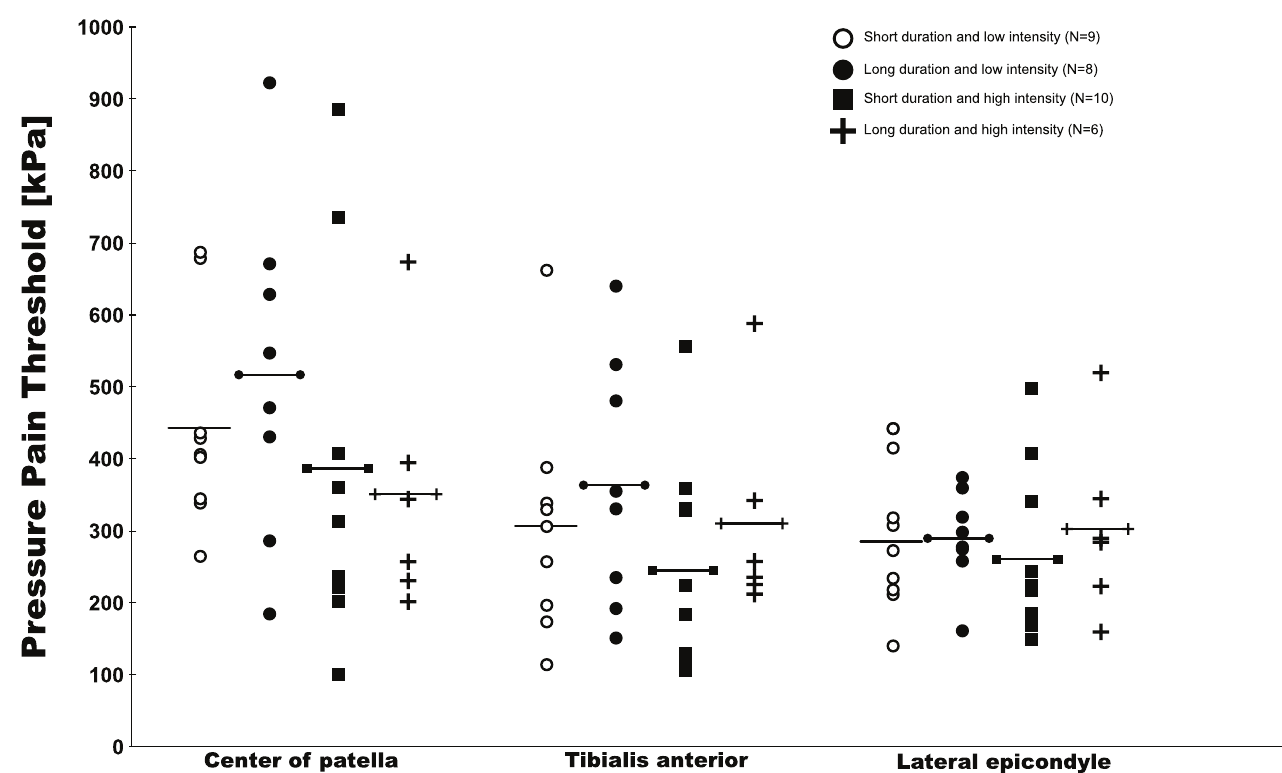
Fig 4. Mechanical PPTs at the three test sites split into four groups based on a median split of pain intensity and duration of symptoms among patients with PFP.